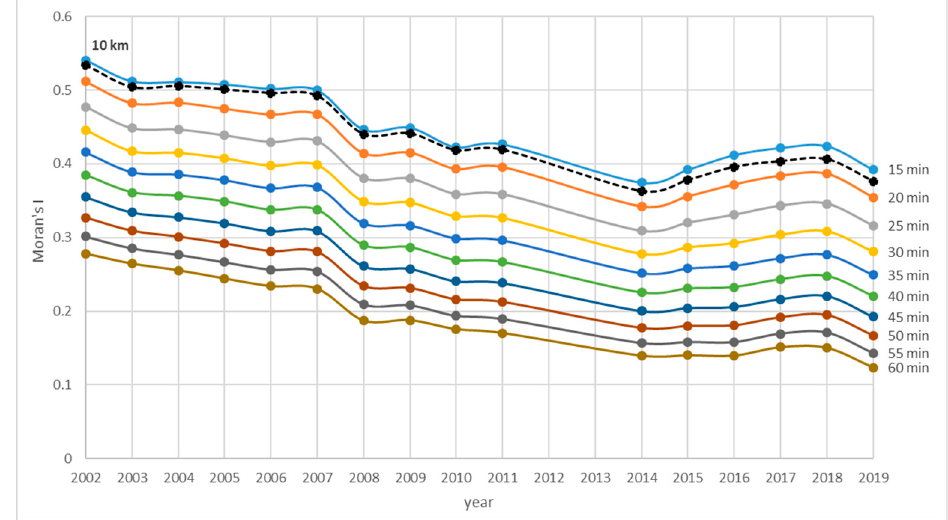
Figure 5. Moran’s I with network spatial weight matrix; unemployment between 2002 and 2019 in Czechia (municipal level). Source: Ministry of Labor and Social Affairs, Labor Office of the Czech Republic; own calculation.